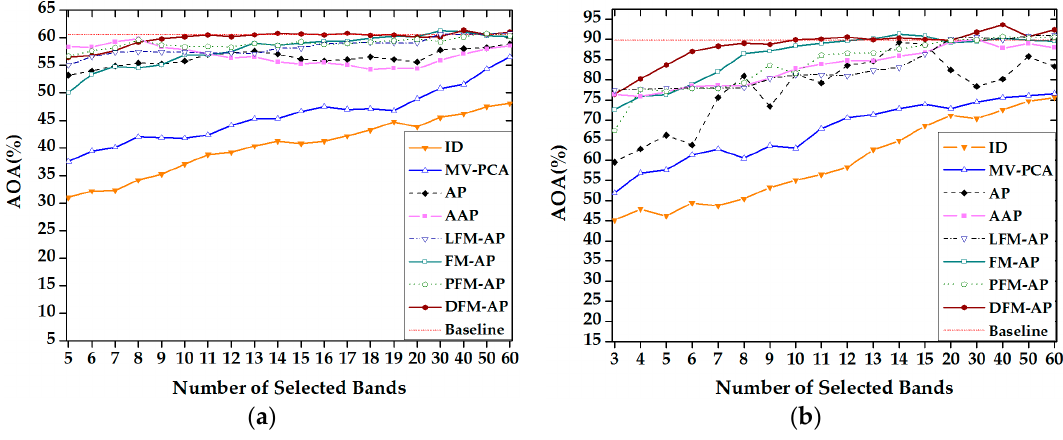
Figure 4. AOA on five trials provided by the SVM compared to the number of selected bands obtained by the ID, MV-PCA, AP, AAP, LFM-AP, FM-AP, PFM-AP and proposed DFM-AP methods with the ( a ) Indian Pines and ( b ) Xuzhou datasets. The results achieved by using all of the spectral channels are also reported (baseline). Table 2. SD of the seven compared methods and proposed DFM-AP compared to the number of selected bands (NB) in the range of 10–60 for the Indian Pines and Xuzhou datasets.